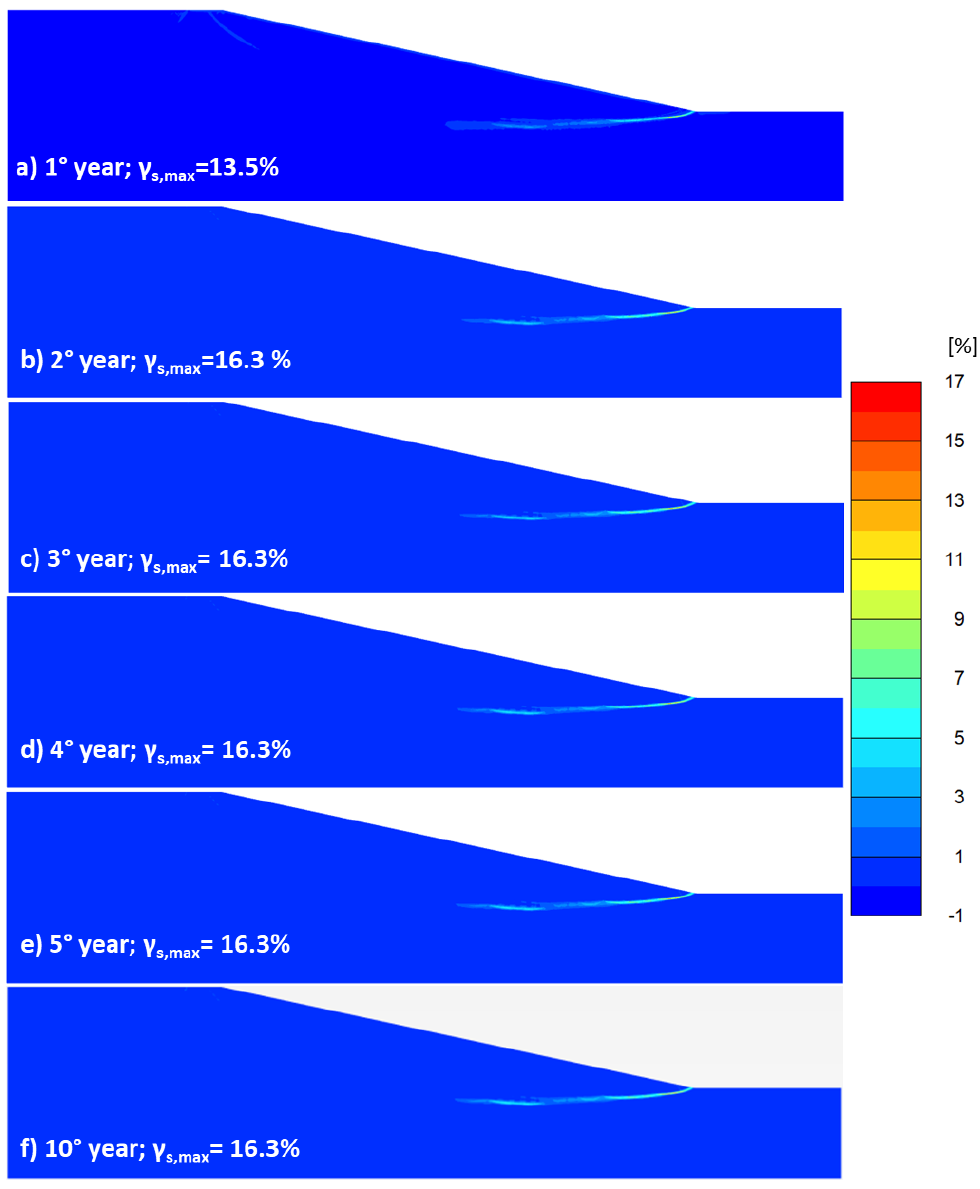
Figure 14. Analysis F: evolution of the progressive failure due to the SLVA interaction in terms of cumulated shear strain during the 10 years of net rainfall; the strain fields refer to the end of the first, second, third, fourth, fifth and 10th years. Figures from a ) to f ) correspond to the results at the end of the 1st, 2nd, 3rd, 4th, 5th, and 10th year of analysis.